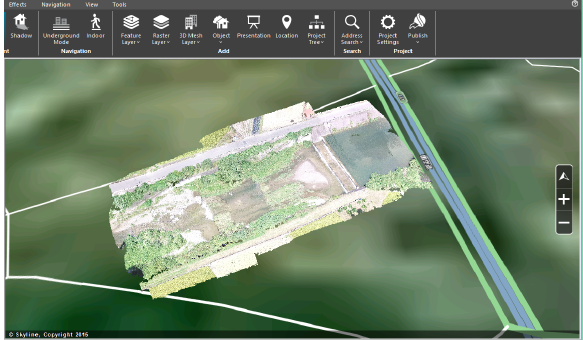
Figure 10. Point cloud data in